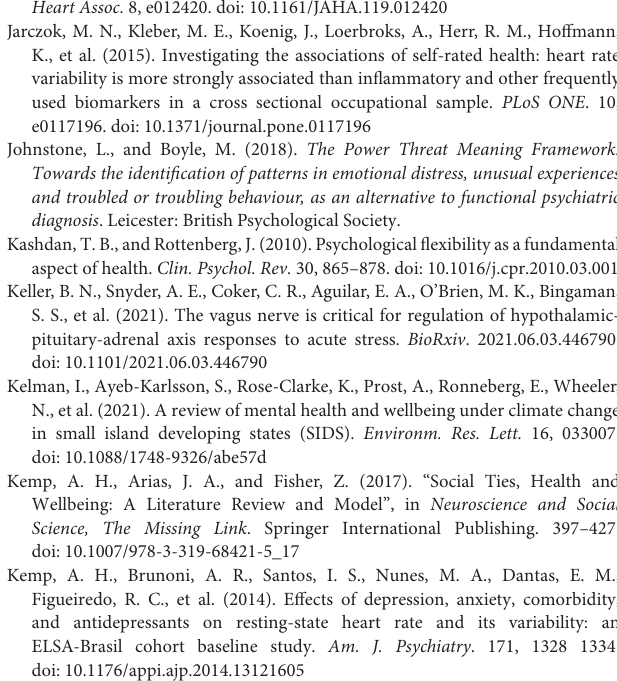
Figueiredo, R. C., et al. (2014). Effects of depression, anxiety, comorbidity, and antidepressants on resting-state heart rate and its variability: an ELSA-Brasil cohort baseline study. Am. J. Psychiatry . 171, 1328 1334. doi: 10.1176/appi.ajp.2014.13121605